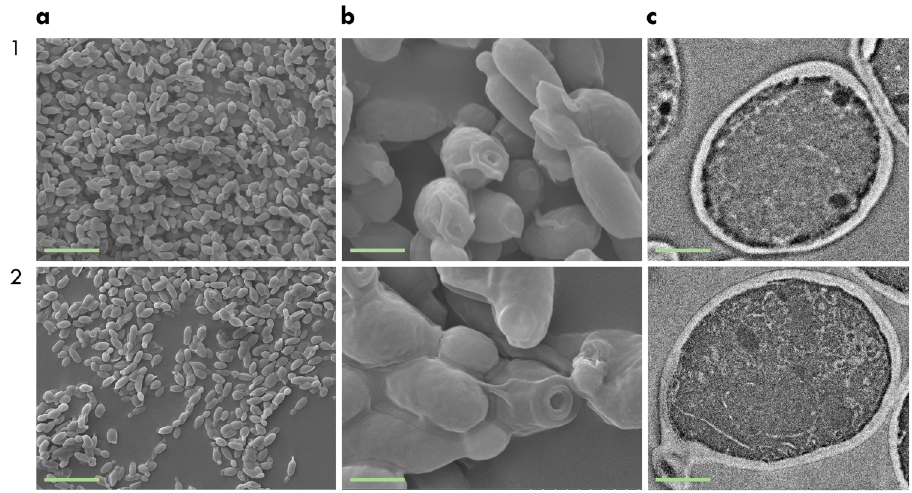
Fig. 3 SEM and TEM imaging of yeast cells. Rows are ordered as follows: control yeast cells ( C 0 : 0 ppb) (1), yeast cells after Pb 2 + biosorption ( C 0 : 100 ppb) (2). a SEM images presenting an overview of yeast cells (scale bar: 10 μ m). b Magni fi ed SEM images showing individual yeast cells (scale bar: 2 μ m). c TEM images of individual yeast cells (scale bar: 1 μ m).